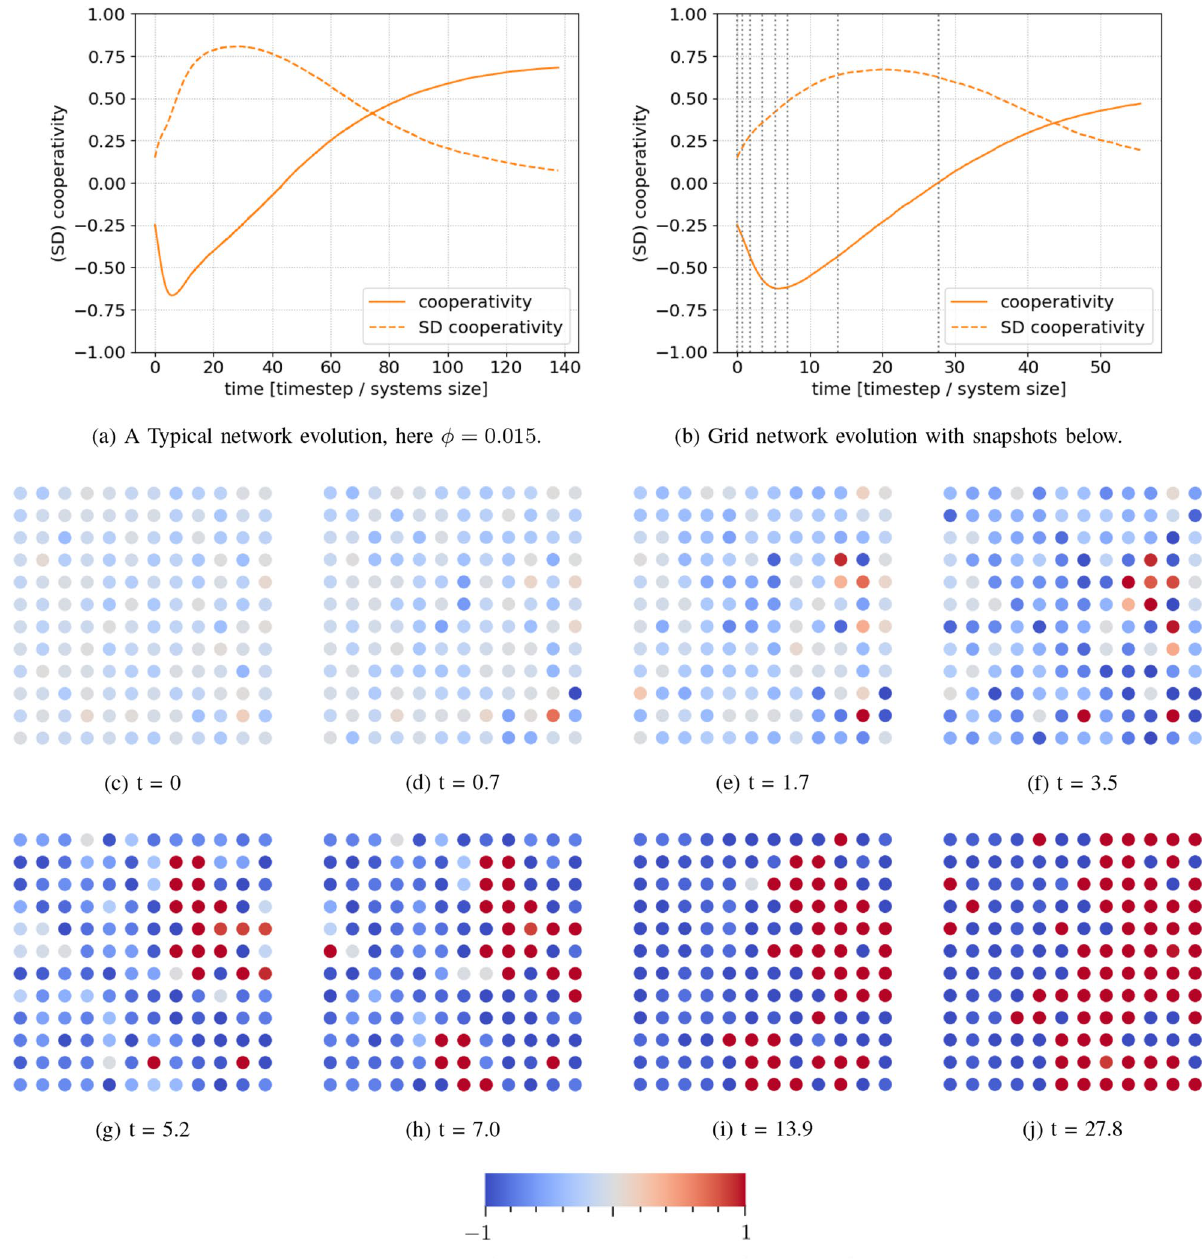
Figure 1. ( a ) A typical average time evolution of the cooperativity for conditions slightly favouring cooperation on a CSF network. At first, the short range but strong social pressure of the initially abundant defectors dominate the evolution. However, after some time, the long-range (global) but weak external field drives the networks slowly into cooperation. The standard deviation initially increases during cluster formation, but later decays away as the network homogenizes. ( b ) An example of how a grid network of small size evolves. Comparing ( b ) with grid snapshots ( c – j ) helps to understand how the clustering process evolves; the dashed lines in ( b ) indicate the times corresponding to ( c – j ). Moreover, comparing ( b ) with ( a ) shows the similarity of dynamics in the grid and CSF network cases. ( c – j ) A realization of a small grid network with periodic boundary conditions and an initial defector majority, but a weak field favouring cooperation. Blue indicates defective behaviour, red cooperative. We see that, initially, agents with strong opinions efficiently convert undecided agents in their vicinity to their cause. This is the cluster-formation regime of the dynamics. In this realization, one can observe a strongly cooperating (red) agent in the upper right, which appears at t = 1.7 . This agent them forms a large cooperative cluster around it. In contrast, most of the rest of the network gradually becomes more defective due to the initial abundance of defectors. At t = 13.9 , the network is almost completely polarised, and by t = 27.8 , the cooperative cluster has begun to overcome the defective cluster by gradually dissolving its